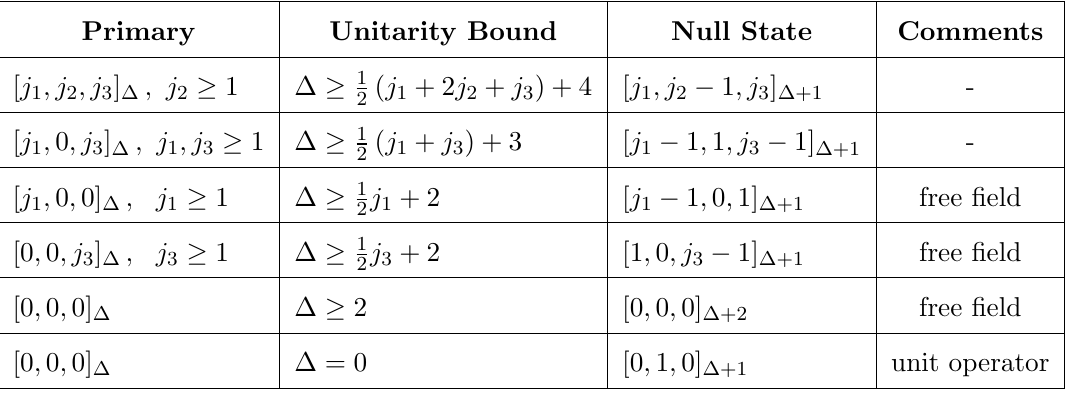
Table 28 . Unitary representations of the conformal algebra in d =